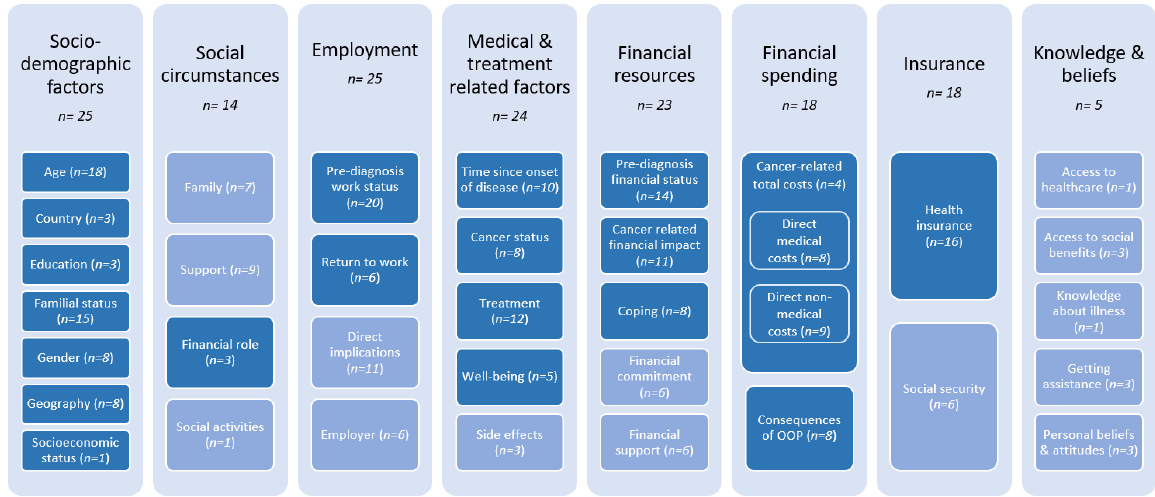
Figure 3. Identified categories of risk factors for financial distress. Categories which showed significant results in quantitative studies are coloured in darker blue. Prevalence of (sub)categories were counted on study level.